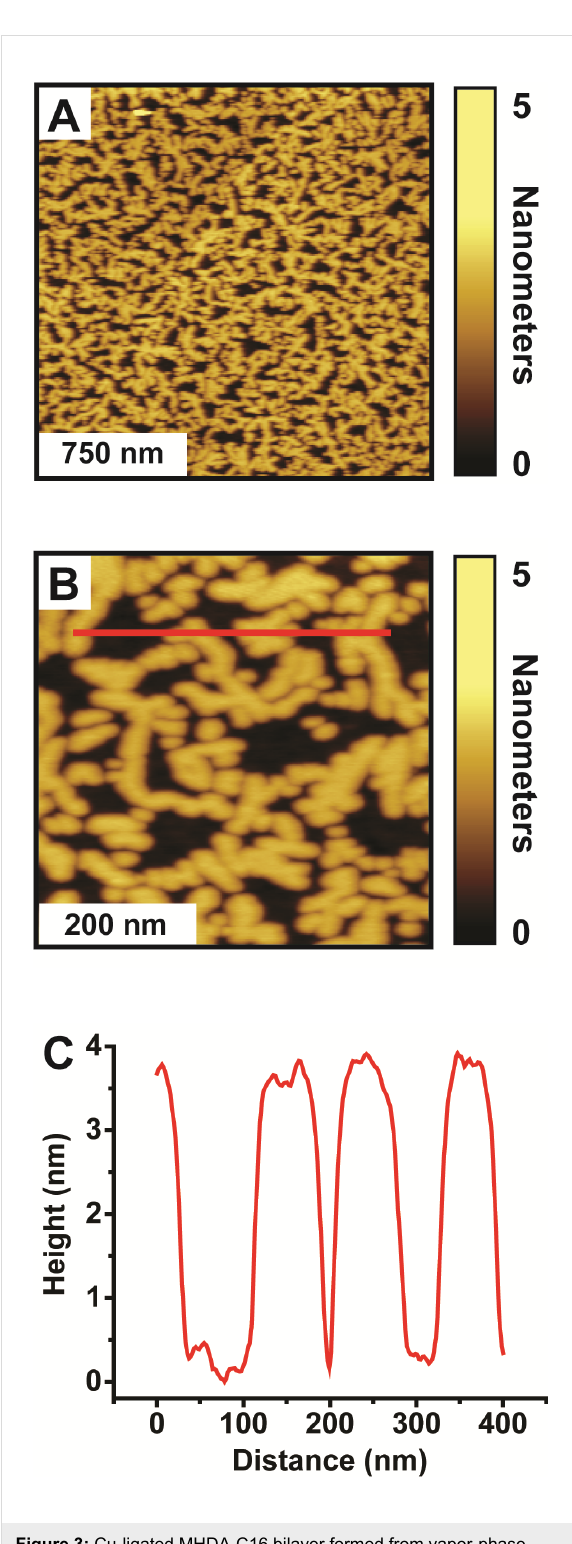
Figure 3: Cu-ligated MHDA-C16 bilayer formed from vapor-phase deposition of C16. Representative (A) 2 µm × 2 µm and (B) 500 nm × 500 nm AFM images of a of a Cu-ligated MHDA-C16 bi- layer formed from the solution deposition of MHDA for 18 h and Cu(ClO 4 ) 2 ·6H 2 O for 5 min and the vapor deposition of C16 for 1 h at 80 °C. (C) Corresponding cursor profile across the C16 islands.